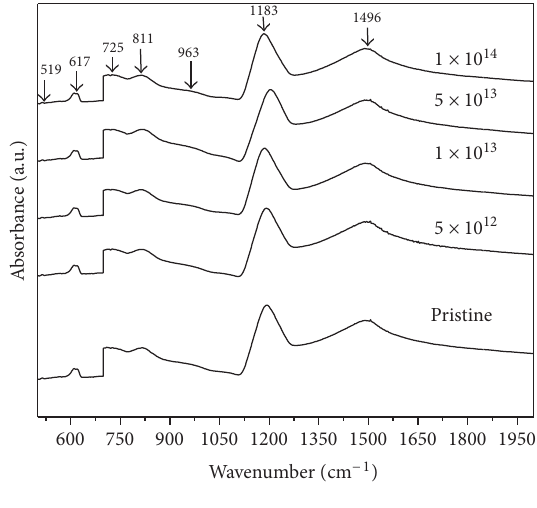
F 7: Shows variation of refractive index for BBiSA and BBiSB glass thin �lm samples as a function of increasing �uence for Ag